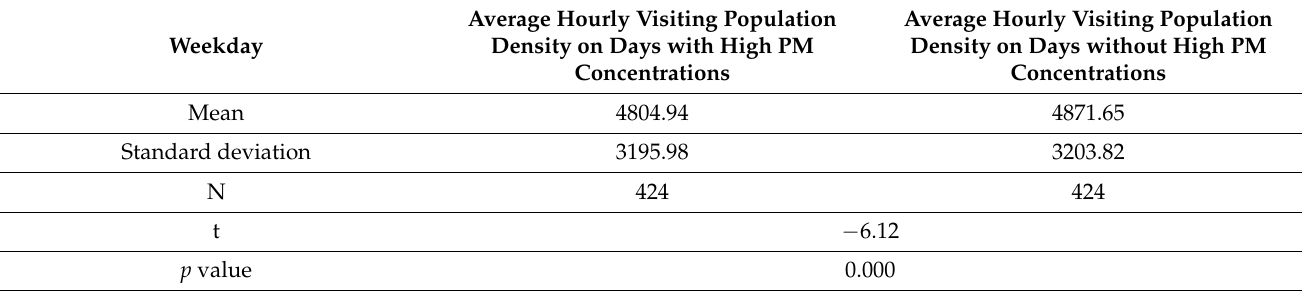
Table 3. t -test results of visiting population changes on weekdays with high PM concentrations and control days.